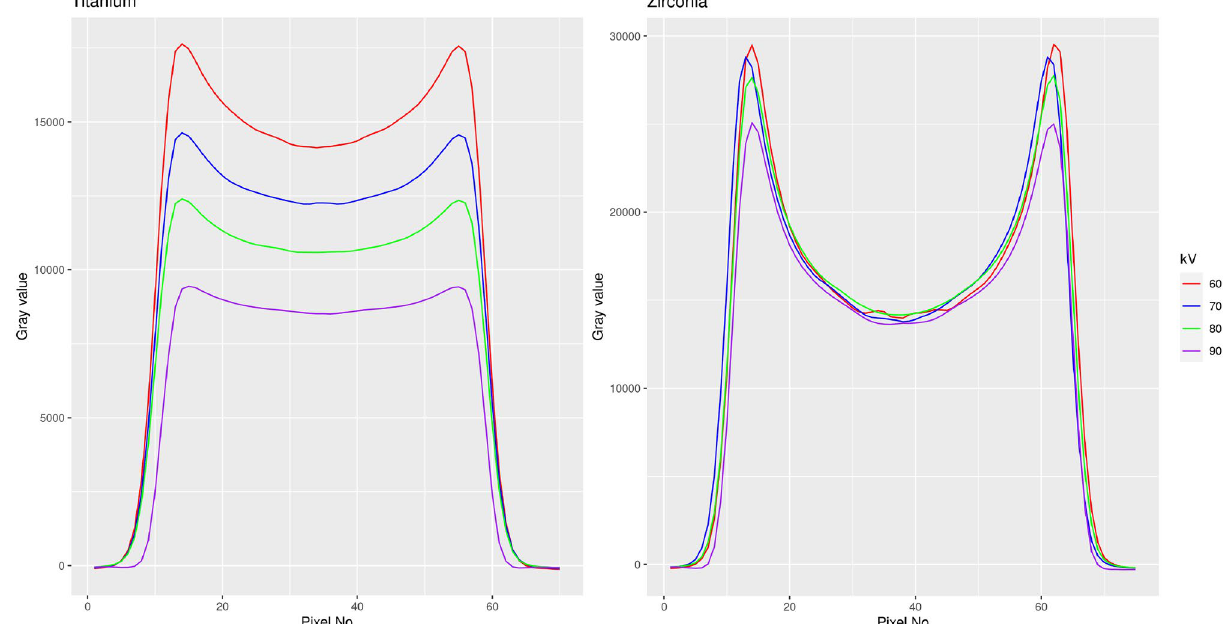
Figure 6. Numerical comparison of the actually occurring beam hardening in the reconstructed 3D CBCT- images of the implant samples. The plot shows averaged gray value-profiles through the implant cross-section (see Fig.5). Note the significant beam hardening artefact for Y-TZP equal for all four energies and representing as a significant reduction in gray value in the center of the implant image of approximately running almost parallel to one another (Fig. 7). In this study, the profile-plot through the CBCT-reconstruction of the implant material shows the beam hardening effect by the centrally significantly lower gray values (Figs. 5 and 6). The latter is far more prominent for Y-TZP, where the gray value reduction centrally accounts for almost 50% of the peak value at the edge of the implant. Also, for Y-TZP there is only 4.9% difference between the cen- tral gray values when comparing 90–60 kVp. For titanium, this difference amounts to 39.8%.